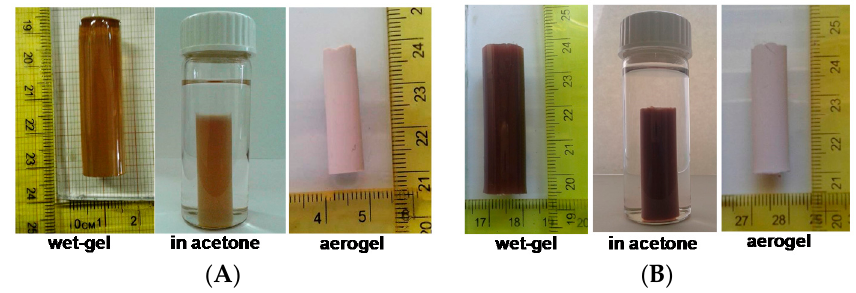
Figure 8. aLNor-xx ( A ) and aRNor-xx ( B ) before and after SCF CO 2 drying.